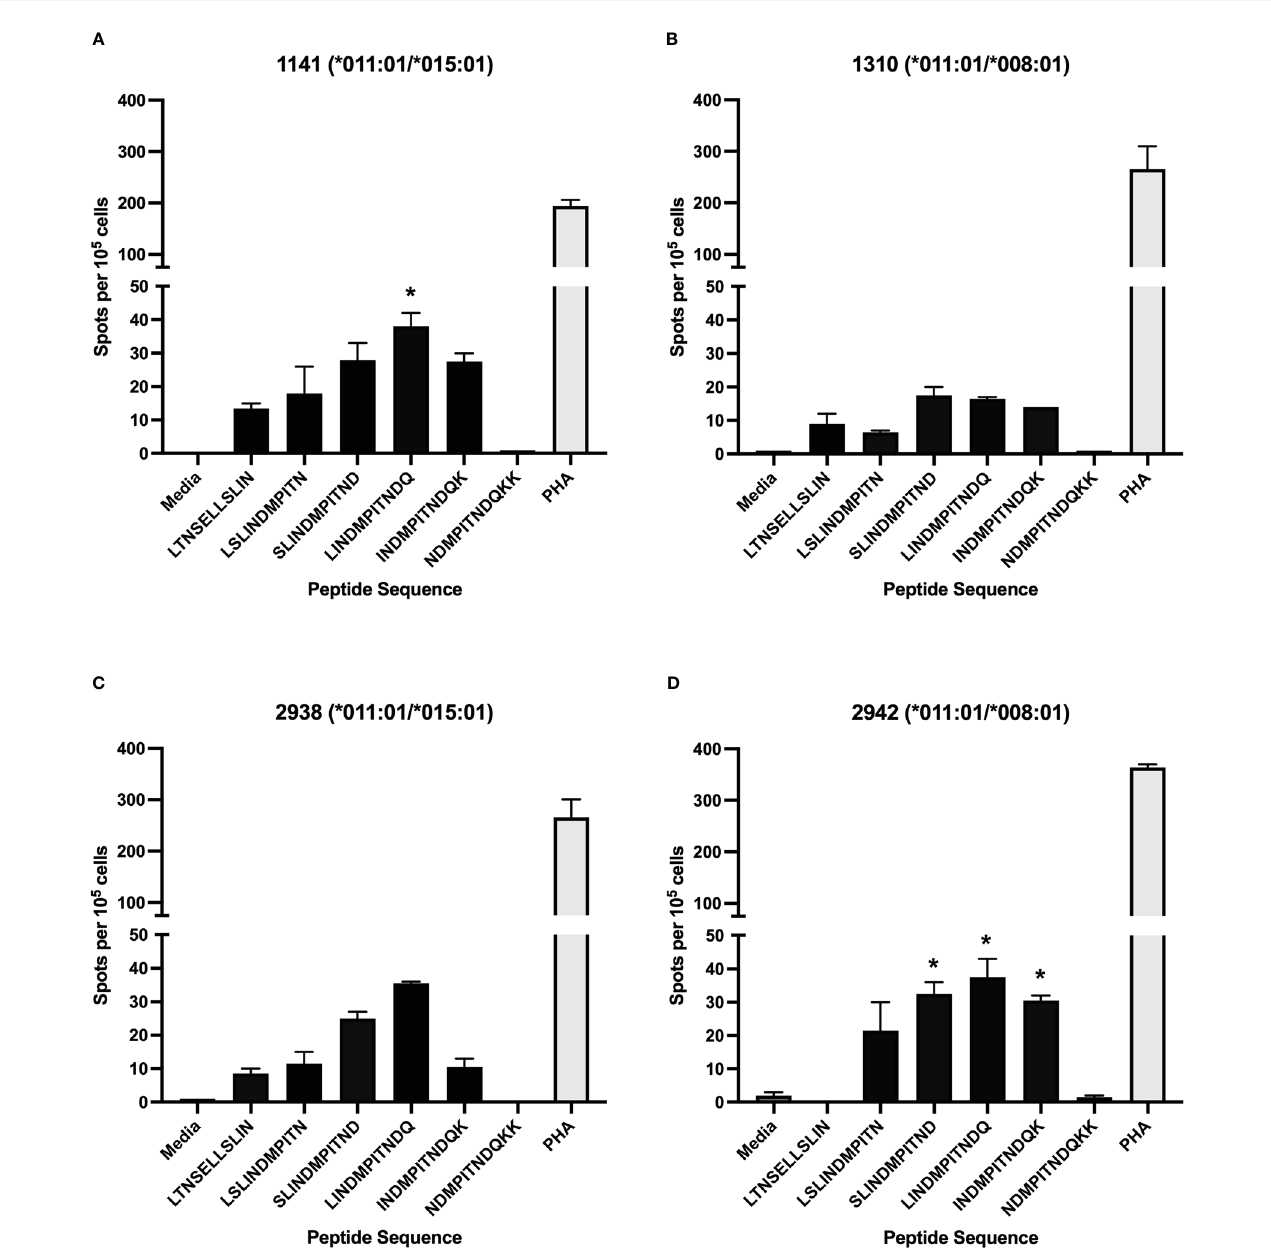
FIGURE 1 Stimulation of CD4 + T cells with synthetic, overlapping peptides from the BRSV-375 F protein. CD4 + T cells from dairy cows were positively selected and cultured with autologous antigen presenting cells loaded with synthetic peptide. T cell activation was assessed via IFN- g secretion using ELISpot assays. Only cells from DRB3*011:01 positive animals responded to stimulation with fi ve out of 88 peptides tested. T cell responses from animals 1141 (A) , 1310 (B) , 2938 (C) , and 2942 (D) displayed a measurable T cell response. Peptides sharing N-terminal amino acid with BRSV-375 F protein residue 253 generated a slight response while those with N-terminal amino acids matching residues 257-260 displayed a larger response. T cells were stimulated with PHA at a concentration of 5 m g/mL as a positive control, and cRPMI media as a negative control. Data presented as mean ± SEM, p < 0.05 was considered signi fi cant and indicated by